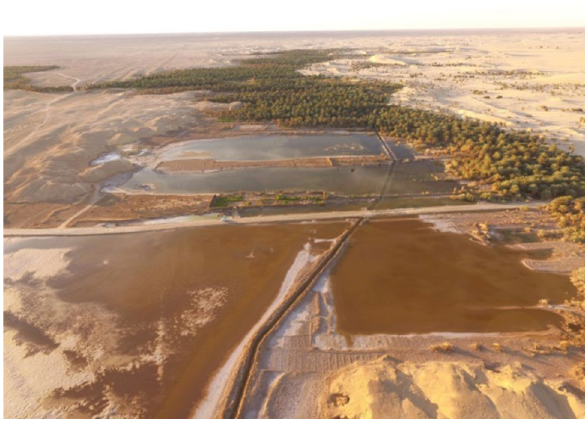
Fig. 18 Flooding of the palm grove of Hadj Amar Kebir. (photo. Authors 2018)